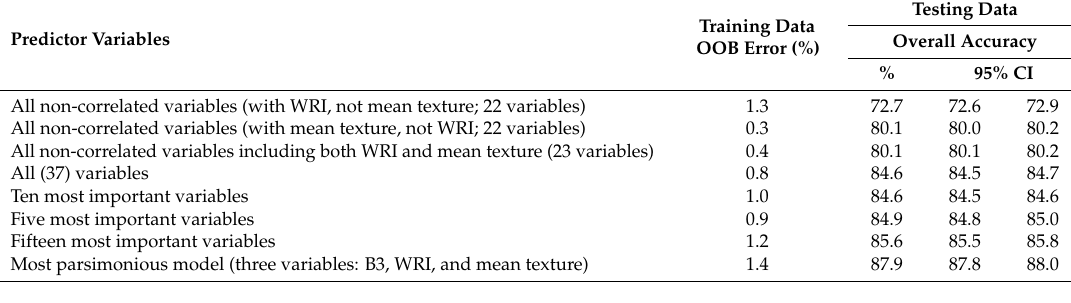
Table 4. Pixel-based random forest classification accuracy on training and testing datasets with various input variable combinations (including 95% confidence interval, CI). The data are sorted based on overall accuracy of the testing